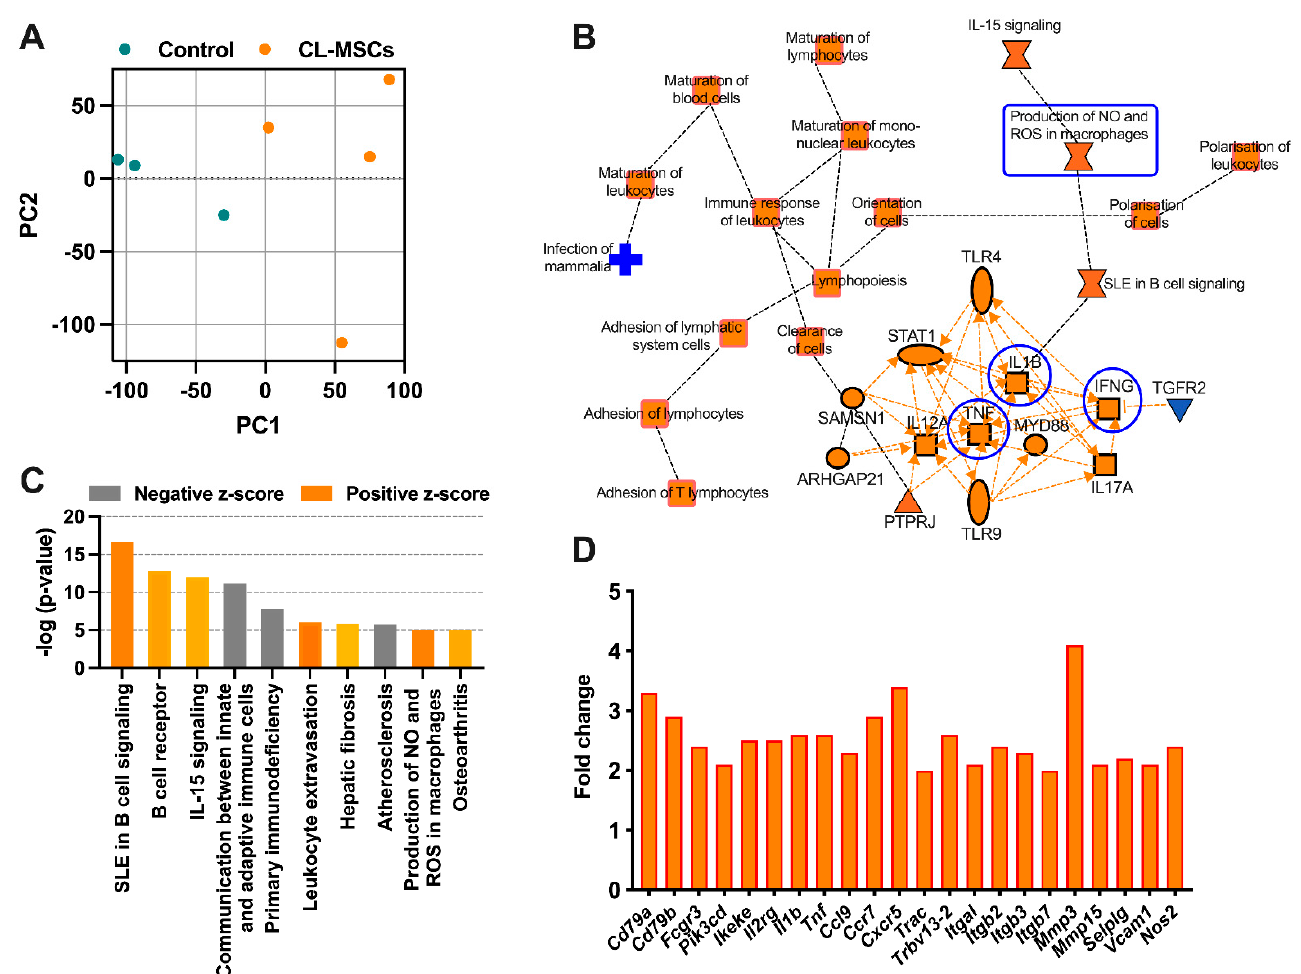
Figure 5. RNA sequencing confirmed CL-MSCs mediate immunomodulation via the concerted action of proinflammatory cytokine-induced chemokines and production of nitric oxide: ( A ) Principal component analysis (PCA) comparing 26-week-old Fas lpr mice treated with four doses of CL-MSCs (n = 4) and 16-week-old Fas lpr mice treated with four doses of dPBS (n = 3). Genes with an adjusted p value for false discovery rate (FDR) less than 0.05 were used for PCA. ( B ) Graphical summary of Ingenuity Pathway Analysis (IPA). ( C ) IPA showing the top 10 pathways identified by comparing CL-MSCs-treated mice versus control mice. A positive z-score represents activation of the pathway; a negative z-score represents inhibition of the pathway. ( D ) The fold change in typical genes involved in the top 10 pathways.